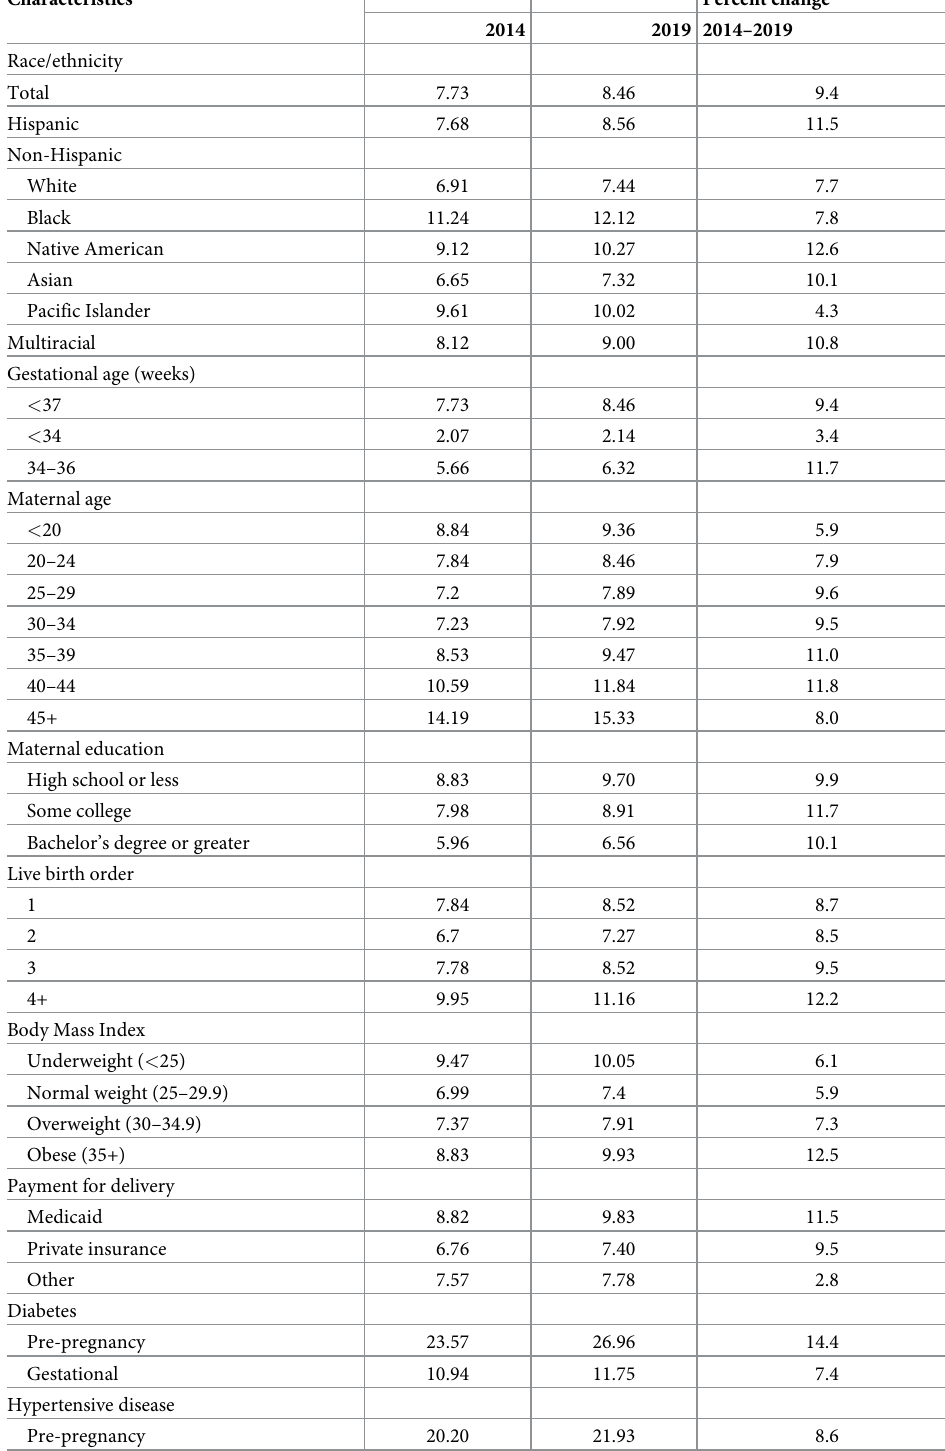
Table 1. Percent of singleton births that were preterm by selected characteristics, United States, 2014 and 2019.